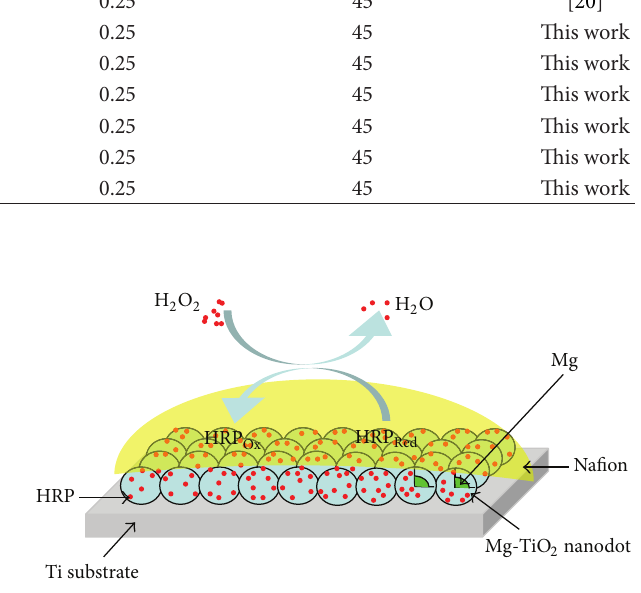
Figure 1: Schematic representation of the hydrogen peroxide biosensor fabricated on